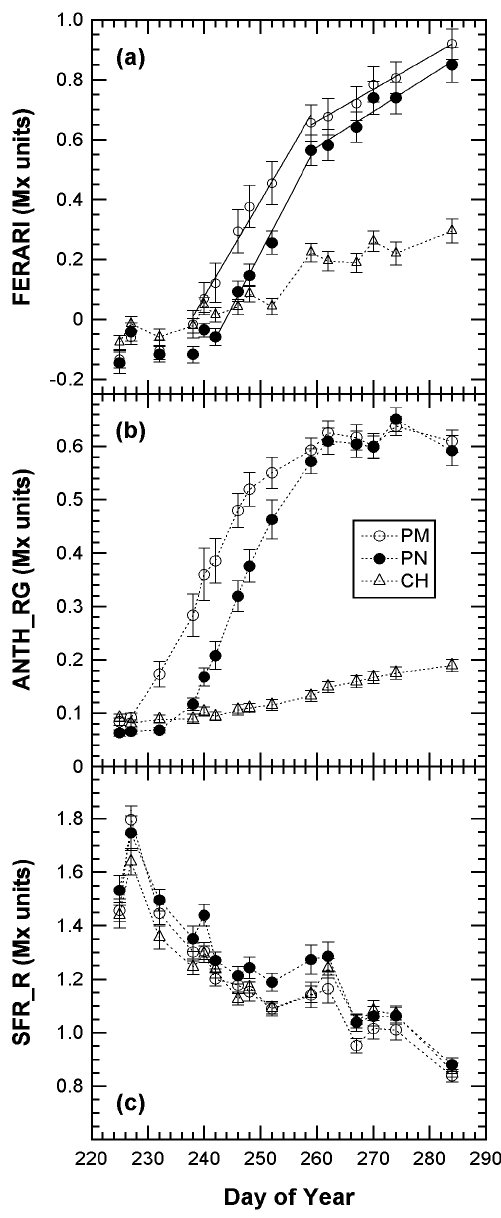
Figure 5. Time course of changed to the Multiplex ® indices during the 2008 season. Mean Multiplex ® index values for 40 marked clusters per cultivar for anthocyanins (a,b) and chlorophyll (c) . CH = Chardonnay, PM = Pinot Meunier, PN = Pinot Noir. Error bars are